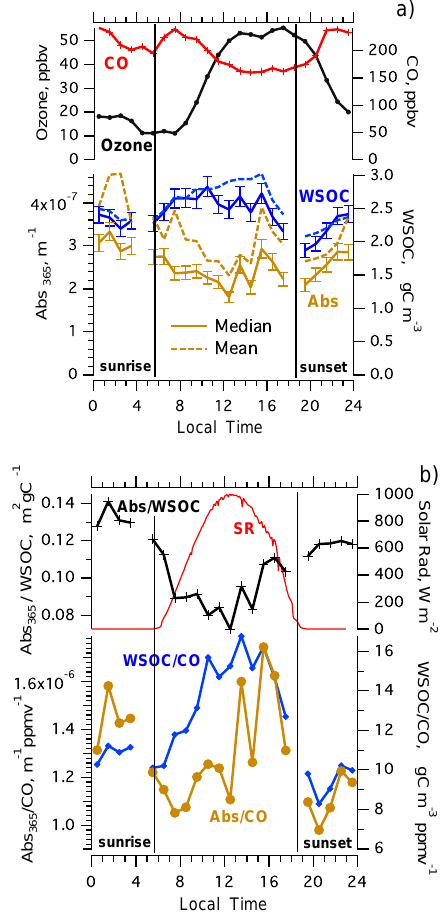
Fig. 8. (a) Hourly medians of Ozone, CO, WSOC and light absorp- tion coefficient at 365nm (Abs 365 ) from online measurements in Atlanta, GA, 1 July to 15 August 2009. Hourly means of WSOC and Abs 365 are also plotted in (a). Variability in WSOC and Abs 365 hourly medians is the standard error. Ratios of hourly medians are shown in the plot along with solar radiation on 11 July (b) . Gaps at 04:00 and 18:00 are periods of dynamic blanks. Number of data points for each hour used to compute medians or means of Abs 365 and WSOC are between 225 and